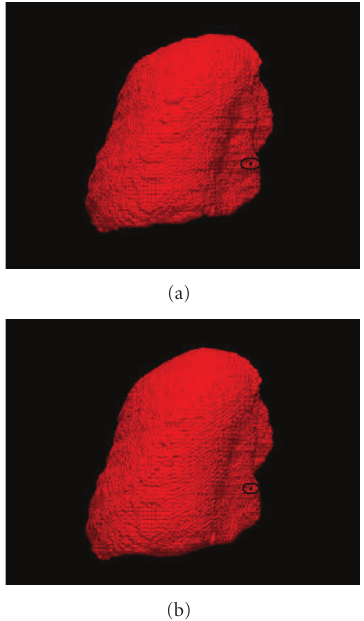
Figure 7: Simulated result of lung deformation at initial stage of inspiration (a) and end of inspiration (b). The dotted mark is the position S3.